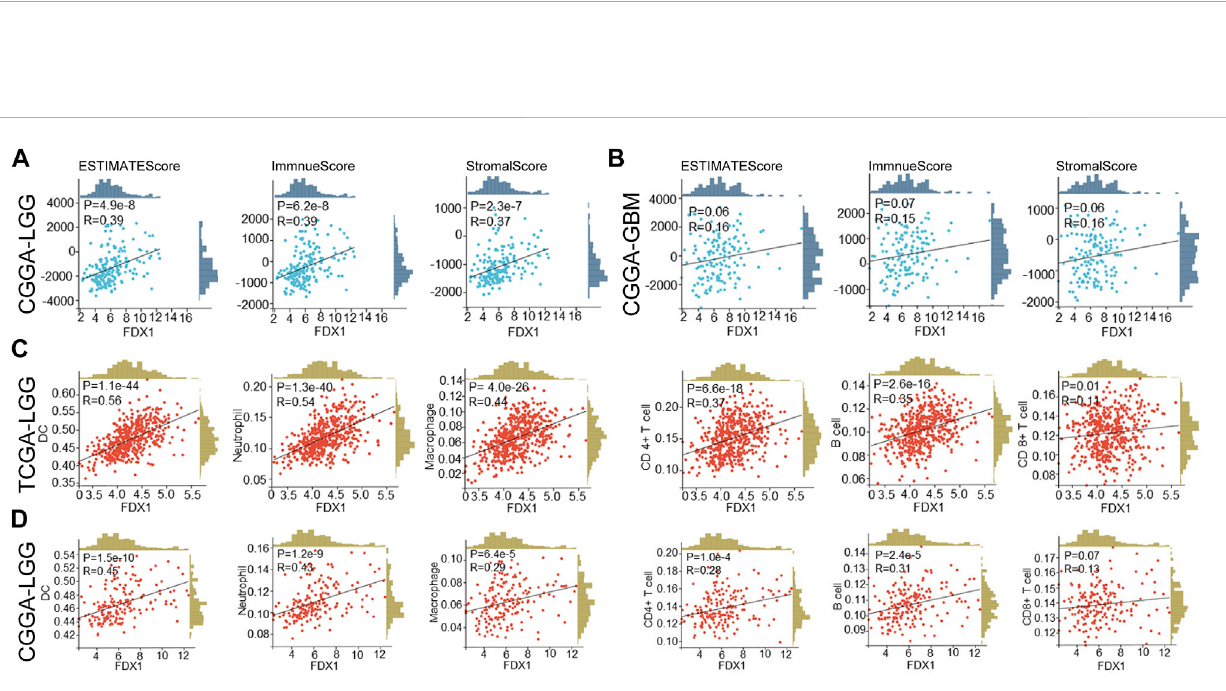
Frontiers in Molecular